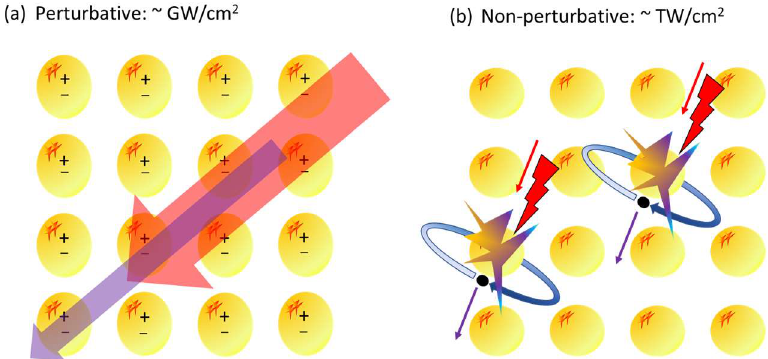
Figure 1. Illustration of the perturbative and non-perturbative interaction of the laser beam with an atomic lattice. ( a ) In the perturbative case, the interaction can be well described as collective nonlinear polarization, ( b ) while in the non-perturbative case, the quantum nature is dominant, and the interactions occur as localized excitation/ionization of the atoms or chemical bonds. Red arrows illustrate the branch of exciting laser photons, and black dots represent electrons moving on trajectories, reaching the neighboring atoms.